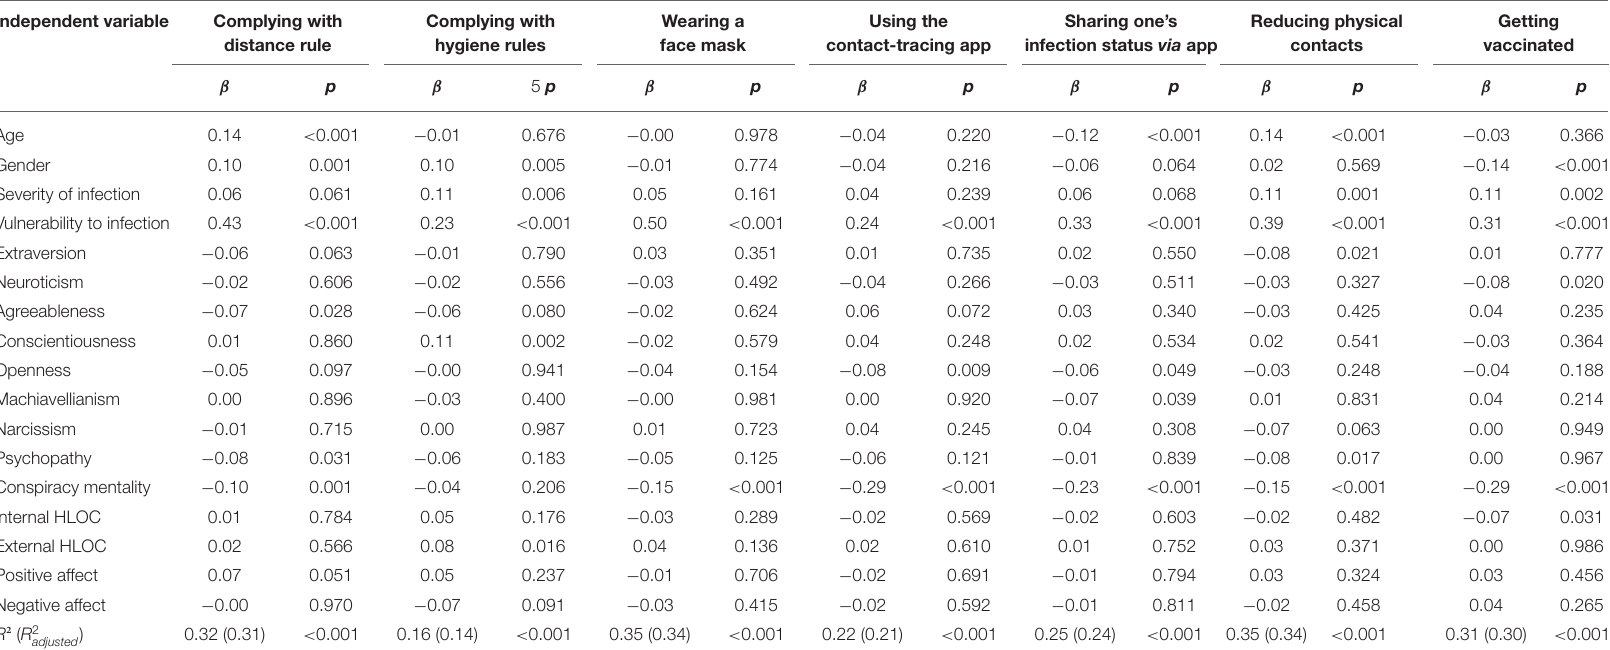
TABLE 4 | Results of the multiple regression analyses for the seven COVID-19 protective